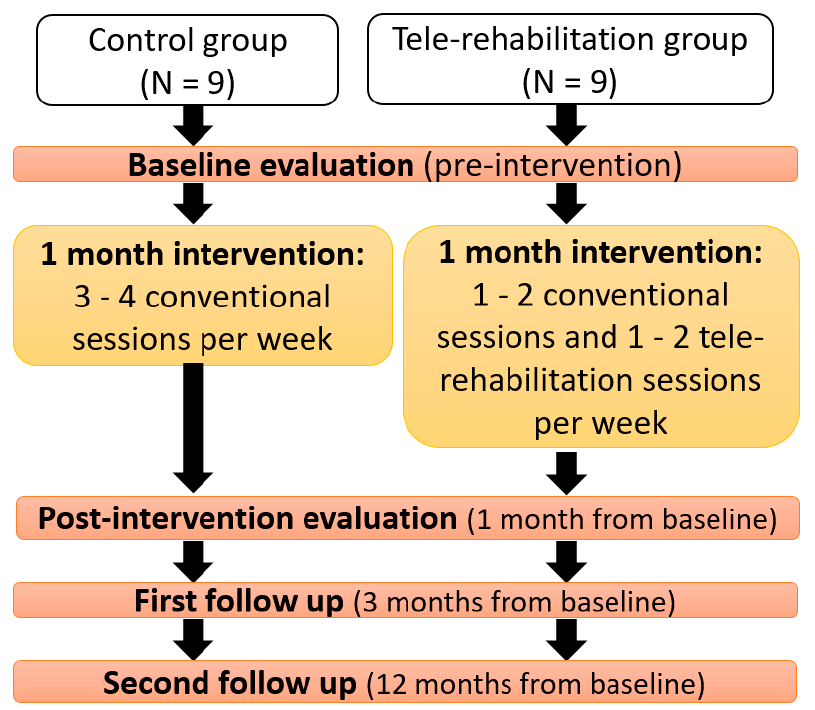
Figure 1. The outline of the study. Table 1. Personal characteristics of the participants in the tele-rehabilitation and control groups. Values are presented as median and interquartile range in